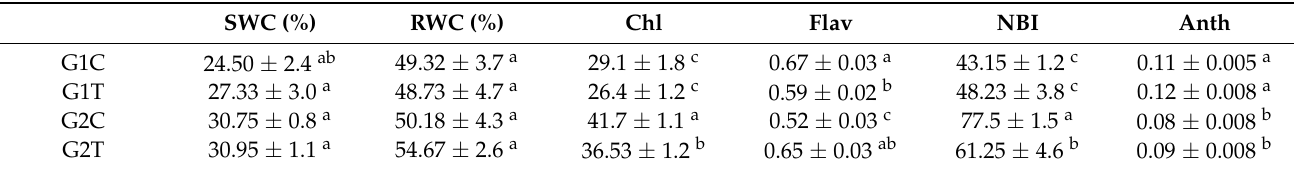
Means with the same letter in the same column are not significantly different from each other according to Tukey’s test ( p < 0.05). Error lines represent ± standard deviation of the mean. Different letters ( a,b,c ) indicate statistically significant differences according to Tukey’s test ( p < 0.05).